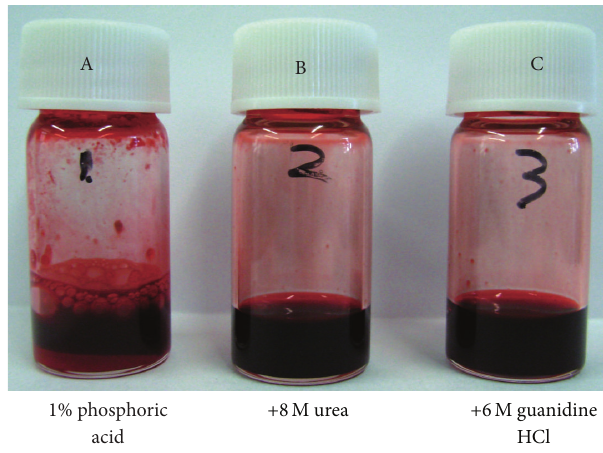
Figure 2: Carmine (Sample A, cochineal extract, Biocon) suspen- sions. (A) is suspended in 1% phosphoric acid. (B) is dispersed in 1% phosphoric acid and 8mol/L urea. (C) is dispersed in 1% phosphoric acid and 6mol/L guanidine